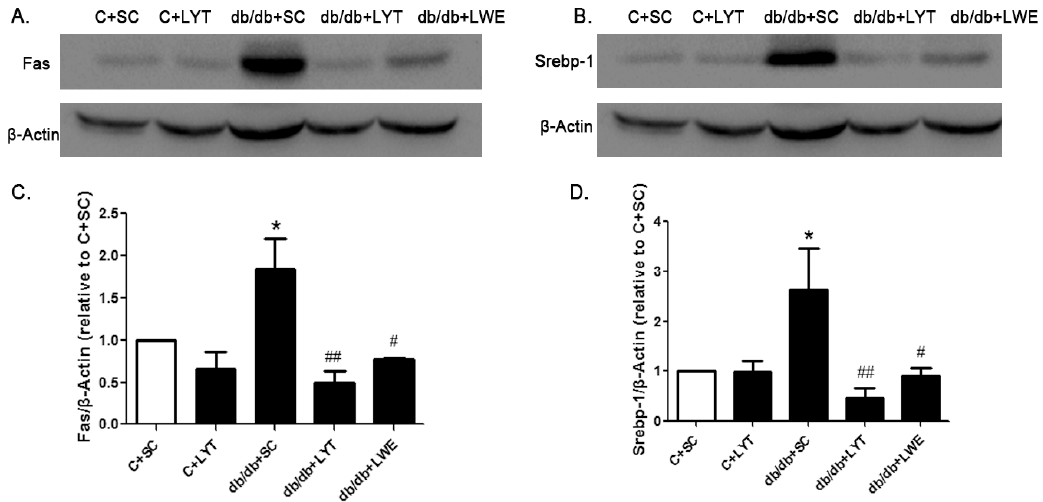
Figure 6. LYT and LWE diets decreased hepatic FAS and SREBP-1 protein expression in db/db mice.